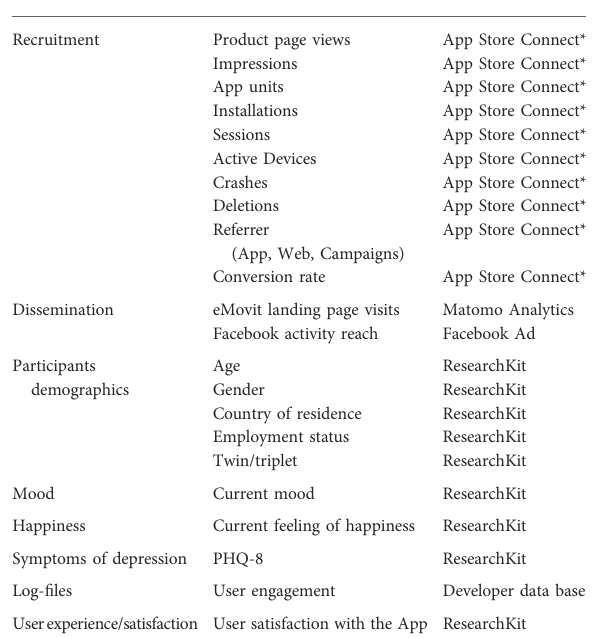
TABLE 1 Data collected within the eMovit